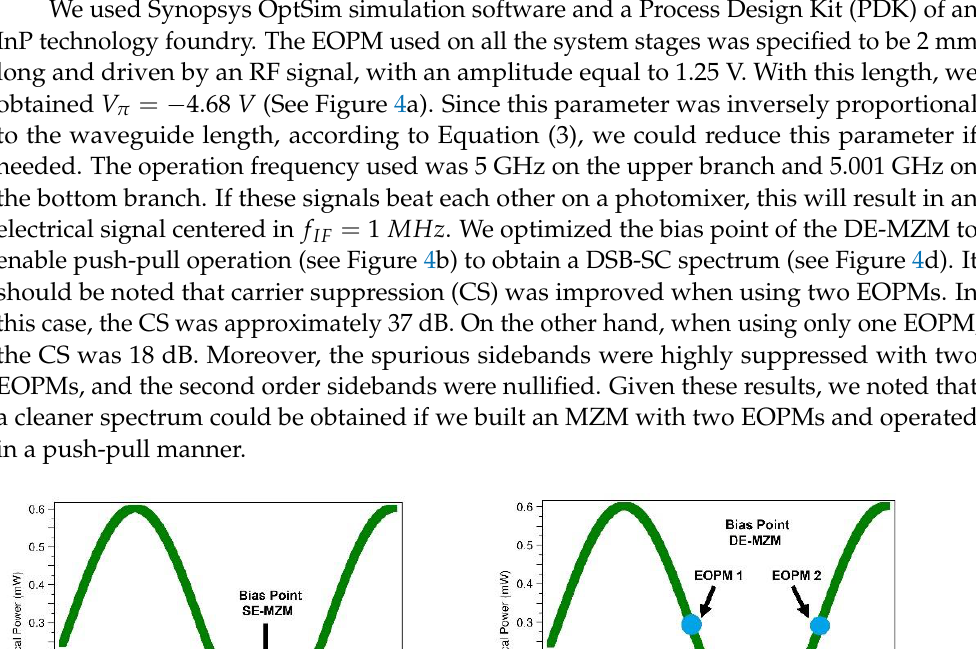
6 of 11 Figure 3. AMZI: Asymmetric Mach-Zehnder Interferometer. EOPM: Phase Modulator. The FSR de- pends on the length difference between the two paths. By applying voltage on the EOPM, we can adjust the central frequency of the filter. This is an optical filter with a simplified structure and op- eration. Practical PIC filters are limited by their FSR, which are in the order of GHz. If we want to filter one sideband without affecting the other, we need to use a frequency on the DSB_SC modulator in the same order as practical or realizable optical filters (i.e., FSR around 5 GHz or more). After the AMZIs are placed, two EOPM are operated by two tones with slightly different frequencies 𝑓 𝑟1 and 𝑓 𝑟2 . When these two combs beat each other, we will obtain a copy of the comb in the electrical domain centered in 𝑓 𝐼𝐹 , with a repetition